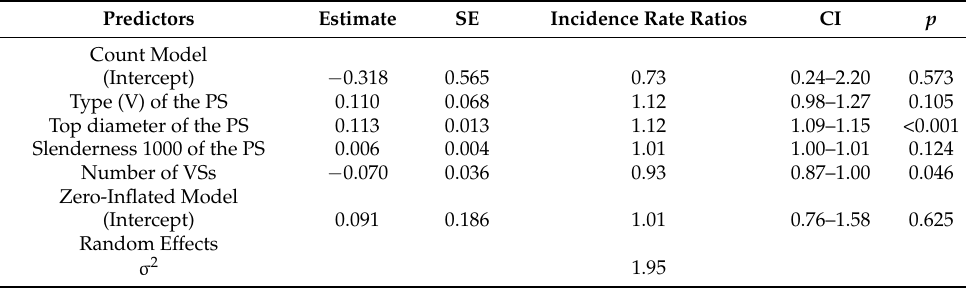
Figure 7. Zero-inflated model of the total yield of the parent shoots (PSs). Note: The higher the Figure 7. Zero-in fl ated model of the total yield of the parent shoots (PSs). Note: The higher the inci- dence rate ratio (>1), the more the yield is positively a ff ected by this variable (black). The lower the incidence rate ratio (>1), the more the yield is positively affected by this variable (black). The lower incidence rate ratio (<1), the more the yield is negatively a ff ected (gray). VS, vegetative shoots. the incidence rate ratio (<1), the more the yield is negatively affected (gray). VS, vegetative shoots. Table 2. Zero-inflated model of the total yield of the parent shoots